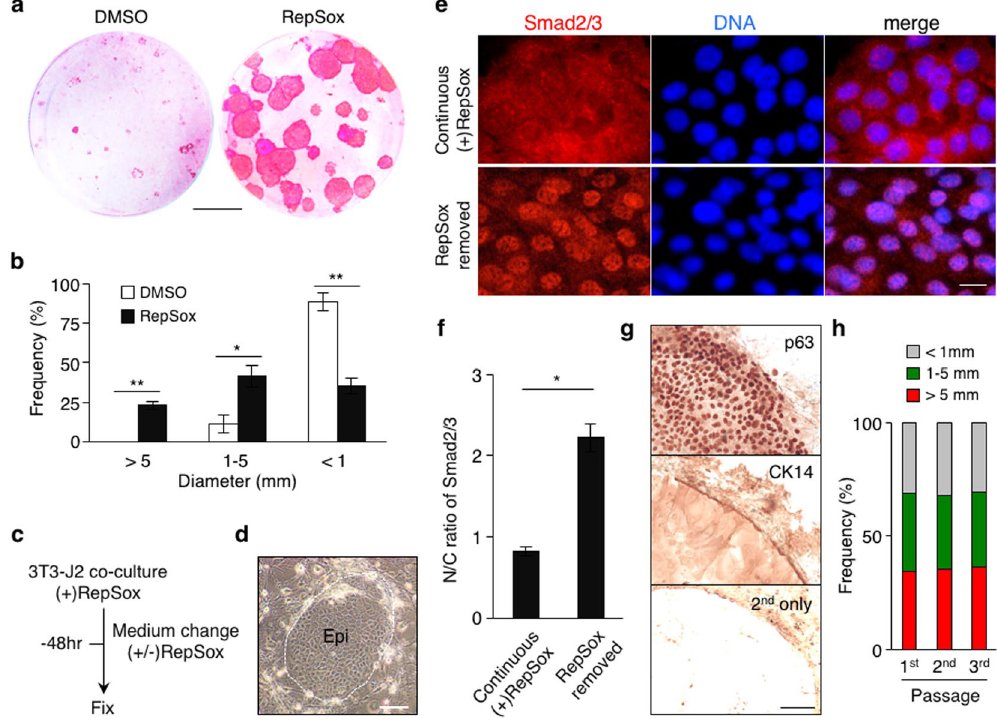
Figure 2. Inhibition of TGF- β signaling supports self-renewal of mouse primary epidermal progenitor cells in serial 3T3-J2 co-culture. ( a ) Rhodamine B staining of newborn mouse-derived, RepSox-expanded P1 epidermal cells grown in 3T3-J2 co-culture in the presence or absence of 1 μ M RepSox for 14 days. Bar = 10 mm. ( b ) Distribution of epidermal clone sizes at day 14. Data shown are mean ± s.e.m. (n = 3). * P < 0.05; ** P < 0.01. ( c – f ) Removal of RepSox associates with nuclear translocation of Smad2/3 in newborn mouse epidermal cells in 3T3-J2 co-culture. ( c ) Experimental scheme. Mouse primary epidermal keratinocytes were grown in 3T3-J2 co-culture in the presence of 1 μ M RepSox. Subsequently, the cultures were maintained in the presence or absence of 1 μ M RepSox for 48 hrs before fixation for immunohistochemistry. ( d ) A representative image of mouse primary keratinocyte clones in 3T3-J2 co-culture. Note that epidermal cell clones show a cobblestone appearance with a distinct clone border (dotted line). Epi , epidermal cell clone. Bar = 50 μ m. ( e ) Representative immunofluorescence images of mouse epidermal cells without (upper) or with (lower) removal of RepSox, stained with anti-Smad2/3 antibodies (left panels) and counterstained with Hoechst 33342 (middle panels). Right panels show merged images. Bar = 10 μ m. ( f ) Nuclear-to-cytoplasmic (N/C) ratios of Smad2/3 as determined by fluorescence intensity. Data shown are mean ± s.e.m. (n = 10). * P < 0.001. ( g ) Immunohistochemistry of representative epidermal cell clones grown in 3T3-J2 co-culture for 14 days in the presence of 1 μ M RepSox, stained with anti-p63 (upper) and anti-CK14 (middle) antibodies. The lower panel represents a control clone stained with the secondary antibodies alone. Data shown are peripheral regions of three different epidermal clones with similar diameter. Bar = 100 μ m. ( h ) Distribution of epidermal clone sizes in serial co-culture with 3T3-J2 cells in the presence of 1 μ M